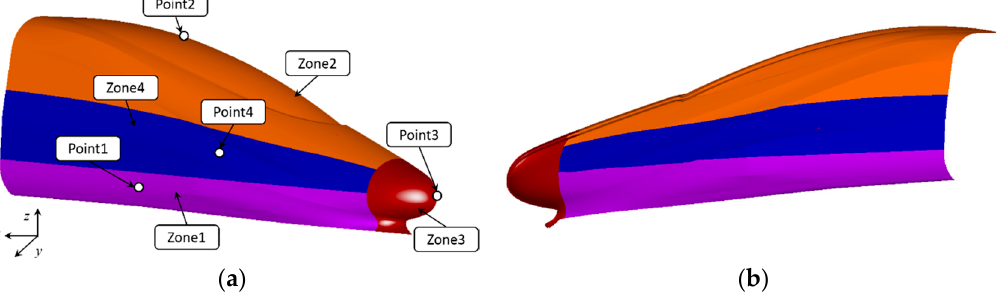
Figure 4. Deformation zones and local deformations: ( a ) schematic of deformation zones; and ( b ) the deformation of the nose and the cab window.